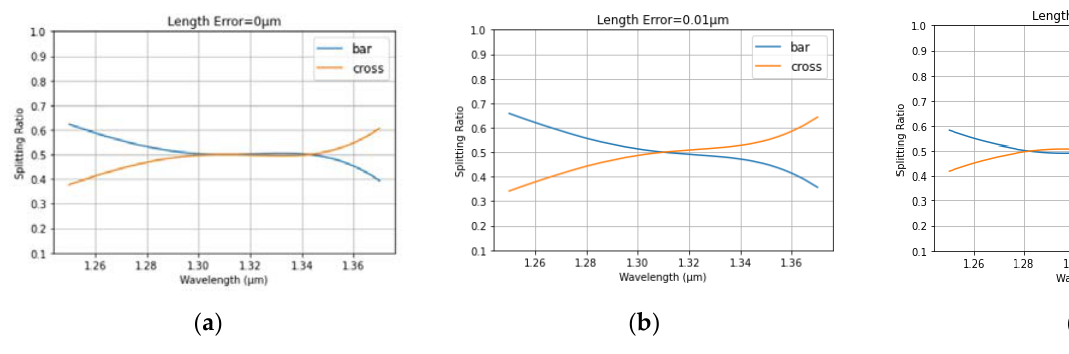
Figure 4. The simulated spectrum response for the unidirectional MZDC ( a ) without the process length shift; ( b ) 10 nm length shift; ( c ) − 10 nm length variation.